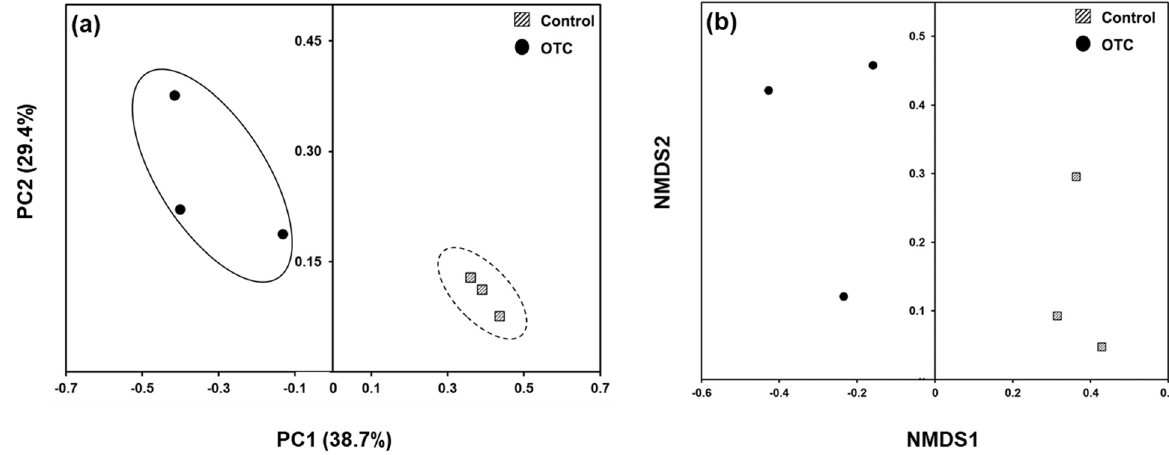
Figure 1. Principal coordinate analysis (PCoA) ( a ) and non-metric multidimensional scaling (NMDS) ( b ) analyses based on Bray–Curtis dissimilatory matrix for gut bacterial community of rainbow trout.